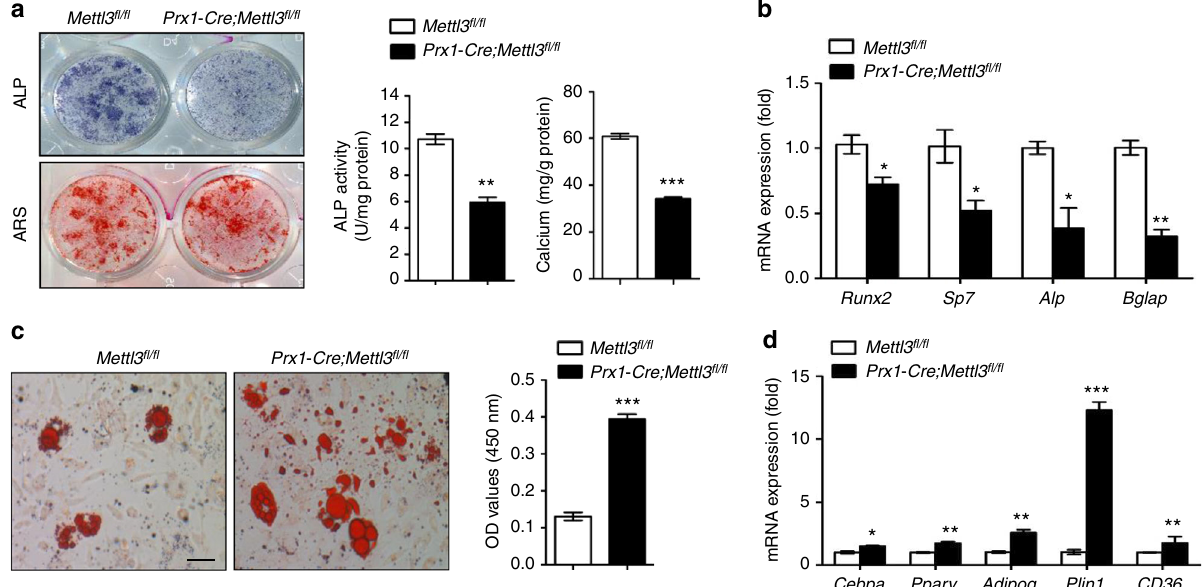
Fig. 2 Mettl3 -de fi cient MSCs exhibit compromised osteogenic potential and increased adipogenic differentiation. a Representative images and quantitative analyses of ALP and ARS staining of MSCs isolated from Mettl3 fl / fl and Prx1-Cre;Mettl3 fl / fl mice. b qRT-PCR analyses of the expression of Runx2 , Sp7 , Alp and Bglap under osteogenic condition. c Representative images and quantitative analysis of oil red O staining. Scale bar, 100 μ m. d qRT-PCR analyses of the expression of Cebp α , Ppar γ , Adipoq, Plin1 , and CD36 under adipogenic condition. Results are from three independent experiments. Data are expressed